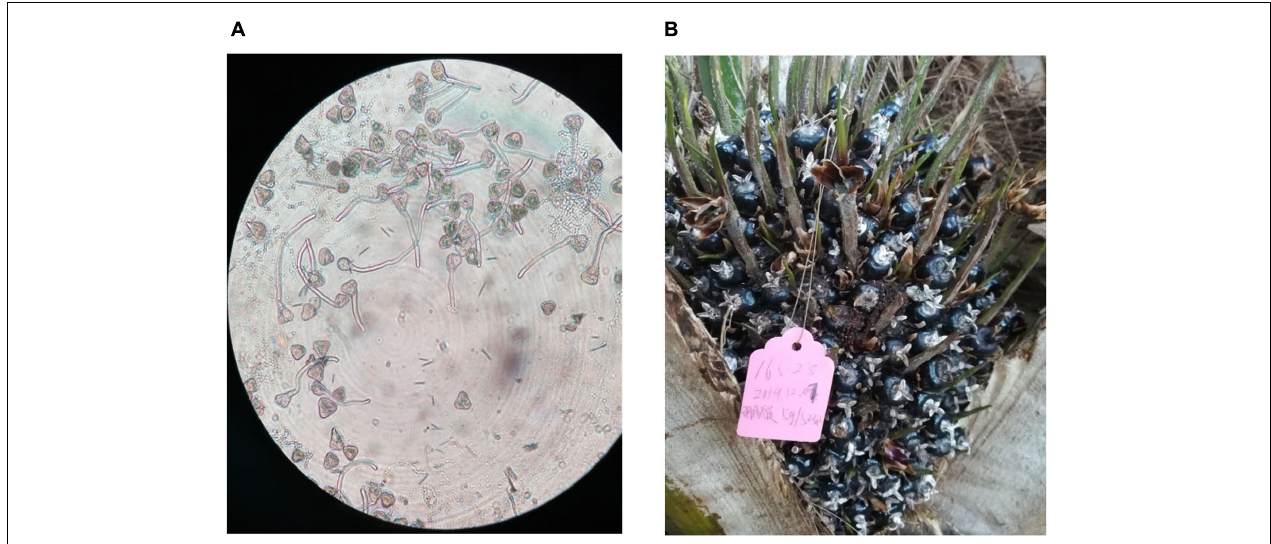
FIGURE 2 | Analysis of the effect of pollination and boron on seedless phenotype. (A) Germinated pollen grains from seedless fruit tree. (B) Fruits developed from boron-treated female inflorescences.